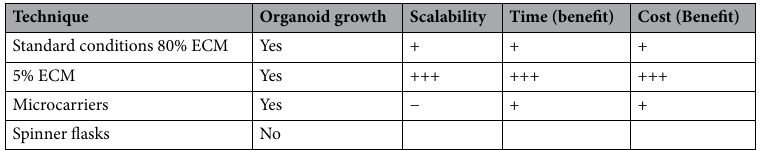
Table 1. Three methodologies tested for organoid culturing compared to standard organoid culturing